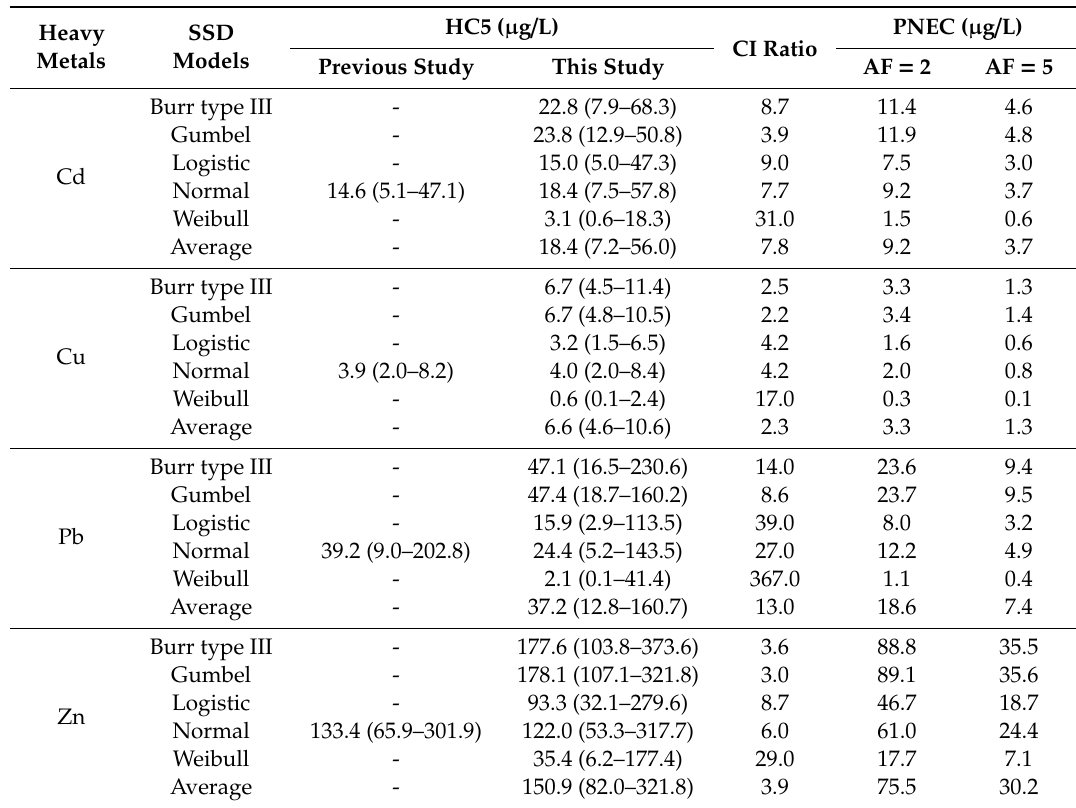
Table 6. The hazardous concentration of 5% of the species (HC5) and predicted no e ff ect concentration (PNEC) values derived from species sensitivity distribution (SSD), with a 95% confidence interval (CI) in